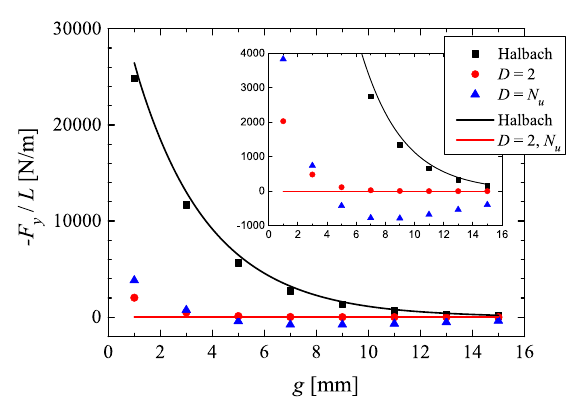
FIG. 6. Analytically (solid lines) and numerically (symbols) calculated magnetic forces for the HU, the PCU ( D ¼ 2 ), and the PCU ( D ¼ N ). u